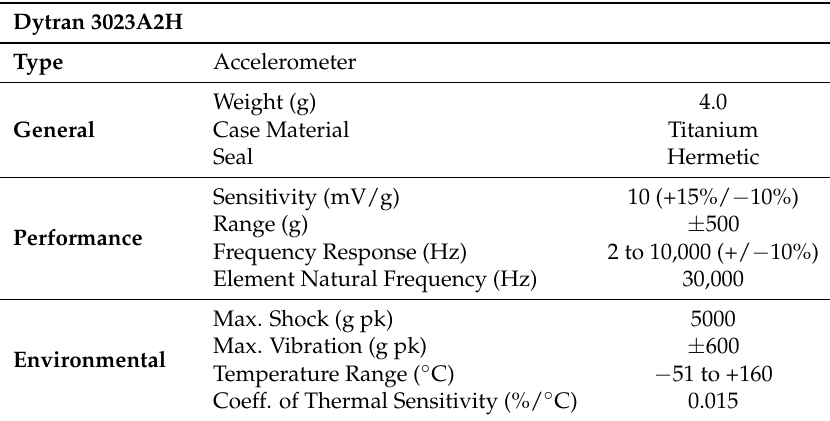
Table A1. Technical specifications of accelerometers Dytran 3023A2H.